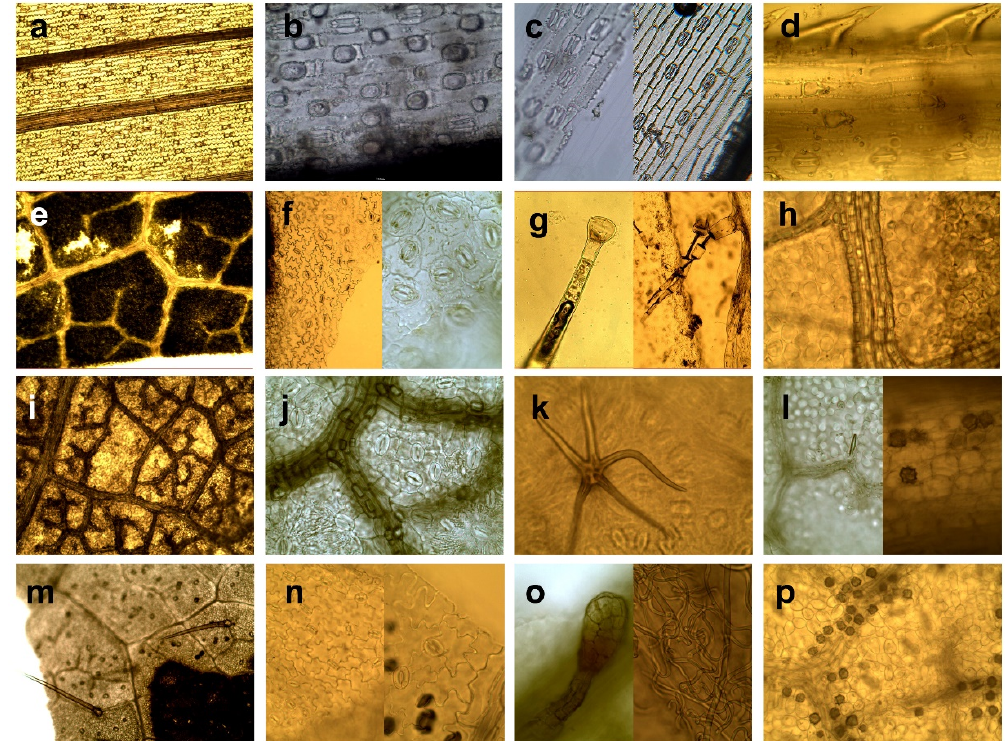
Figure 1. ( a ) parallel venation on leaf of Agrostis stolonifera L., abx (100 × ); ( b ) regular-shaped cells arranged in rows on leaf of Calamagrostis epigejos L. Roth., abx (100 × ); ( c left ) stomata parallel with long cells on leaf of Calamagrostis epigejos , adx (400 × ); ( c right ) dumbbell shape of guard cells of stomata on leaf of Phleum pratense L., abx (100 × ); ( d ) prickles on leaf margin of Deschampsia cespitosa , adx (400 × ); ( e ) reticulated venation on leaf of Aegopodium podagraria L., abx, (100 × ); ( f , left ), irregular-shaped cells on leaf of Lathyrus niger (L.) Bernh., adx (100 × ); ( f right ) kidney shape of guard cells of stomata on leaf of Betonica officinalis L., abx (400 × ); ( g left ) glandular trichome on leaf of Saponaria officinalis L., abx (400 × ); ( g right ), trichomes on leaf of Impatiens parviflora D. C., abx (100 × ); ( h ) prisms in rows over vascular bundles on leaf of Vicia sepium L., adx (400 × ); ( i ) reticulated venation on leaf of Populus sp. abx (100 × ); ( j ) stomata randomly arranged on leaf of Tillia cordata Mill., abx (400 × ); ( k ) stellate trichome on leaf of Quercus cerris L., abx (400 × ); ( l ) needle-like crystal on leaf of Robinia pseudoacacia L., adx (400 × ); ( m ) almost straight trichomes on leaf of Rubus caesius L., abx (400 × ); ( n left ) irregular-shaped cells on leaf of Rubus caesius , abx (400 × ); ( n right ) randomly arranged stomata on leaf of Rubus saxatilis L., abx (400 × ); ( o left ) tongue-shaped trichome on leaf of Vaccinium myrtillus L., abx (400 × ); ( o right ) twisted and convoluted simple trichomes on leaf of Rubus idaeus L., abx (400 × ); ( p ) druses on leaf of Rosa canina L., abx (400 ×